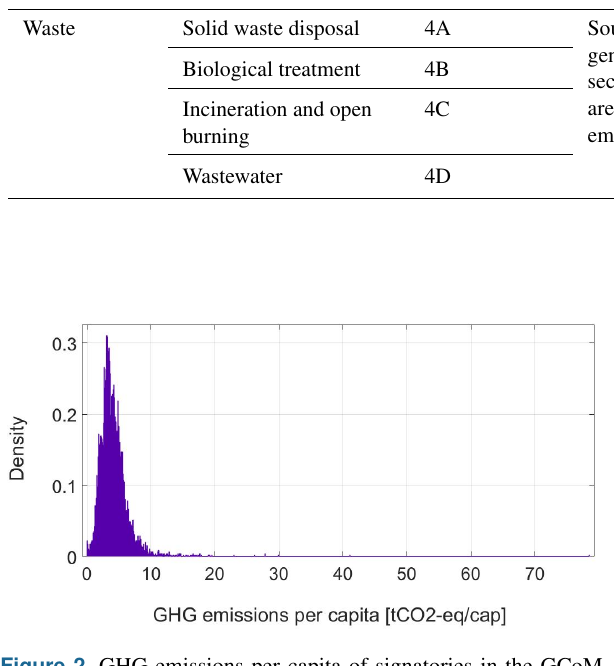
Figure 2. GHG emissions per capita of signatories in the GCoM dataset 2019, showing the frequency distribution of GHG emis- sions per capita from the emission inventories dataset, with obser- vations that range from 0 to 80tCO 2eq per capita, with a mean of 5.18tCO 2eq per capita. This comprehends the emissions from all the GCoM sectors (stationary energy, transportation and waste), ex- cluding manufacturing and construction industries. On the vertical axis the density values are reported, i.e. the share of signatories with the same range of GHG emissions per capita, by the width of the range (0.01 in this